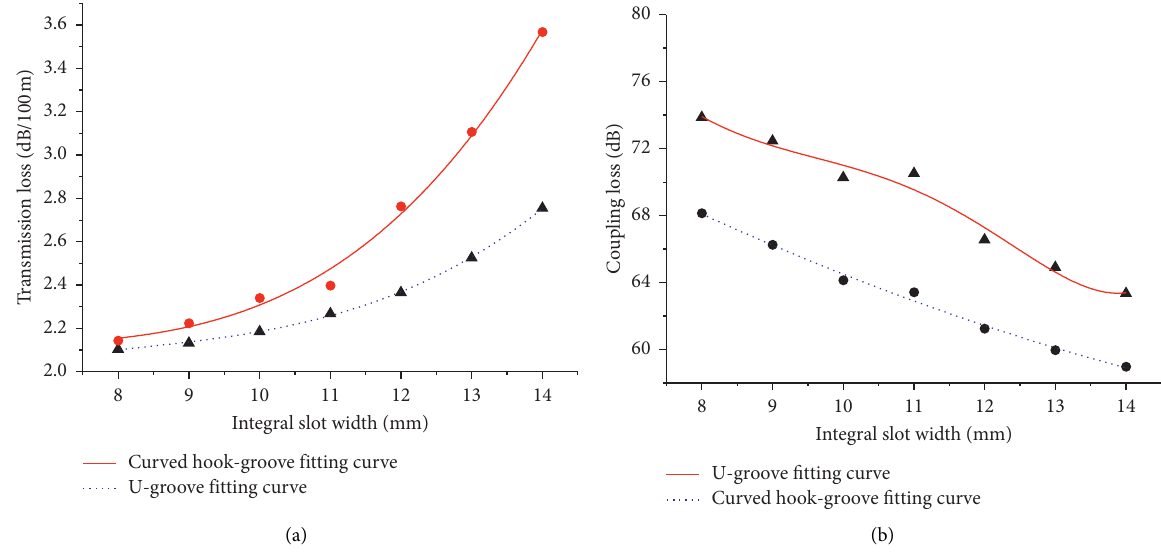
Figure 16: Trend of influence of groove width of U-groove and curved hook groove on the loss of leakage